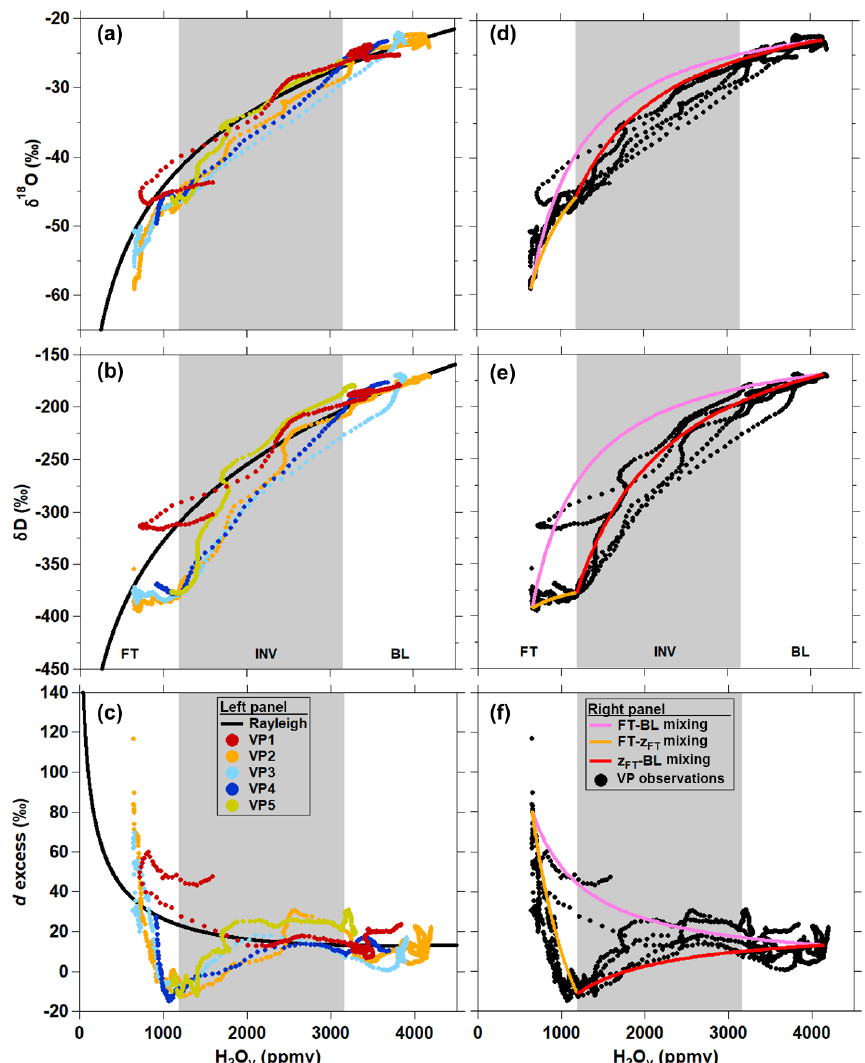
Figure 9. Comparison of vertical profile δ 18 O (a, d) , δ D (b, e) , and d excess (c, f) measurements to Rayleigh theory (a, b, c) and mixing (d, e, f) curves for STC (MAR04). Individual VP descents are indicated by the differently colored points. The bounds of the inversion layer (INV), indicated by grey shading, are defined by the average H 2 O v mole fractions observed at z INV and z FT